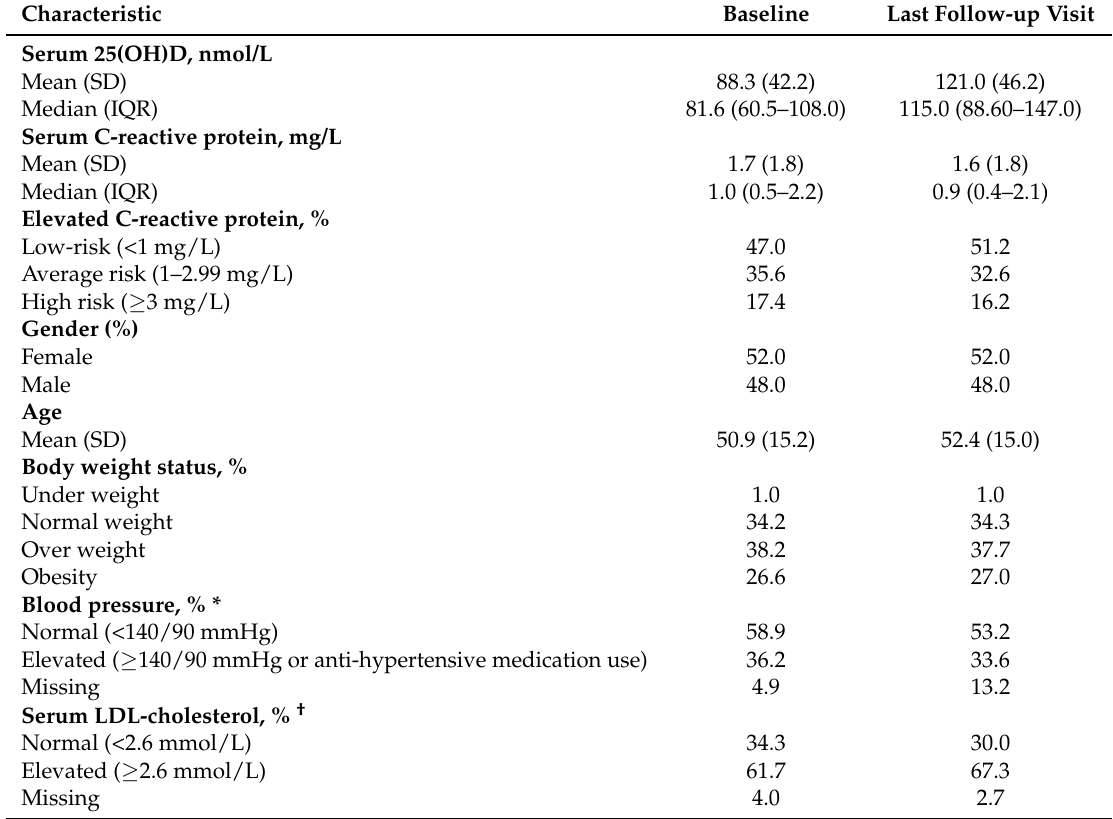
Table 1. Baseline and follow-up characteristics of 6755 study